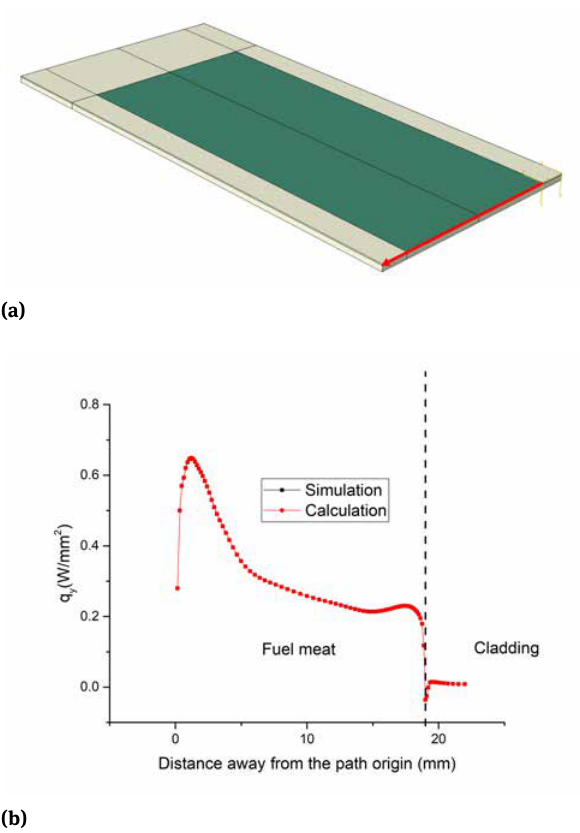
Figure 7: Verification of heat